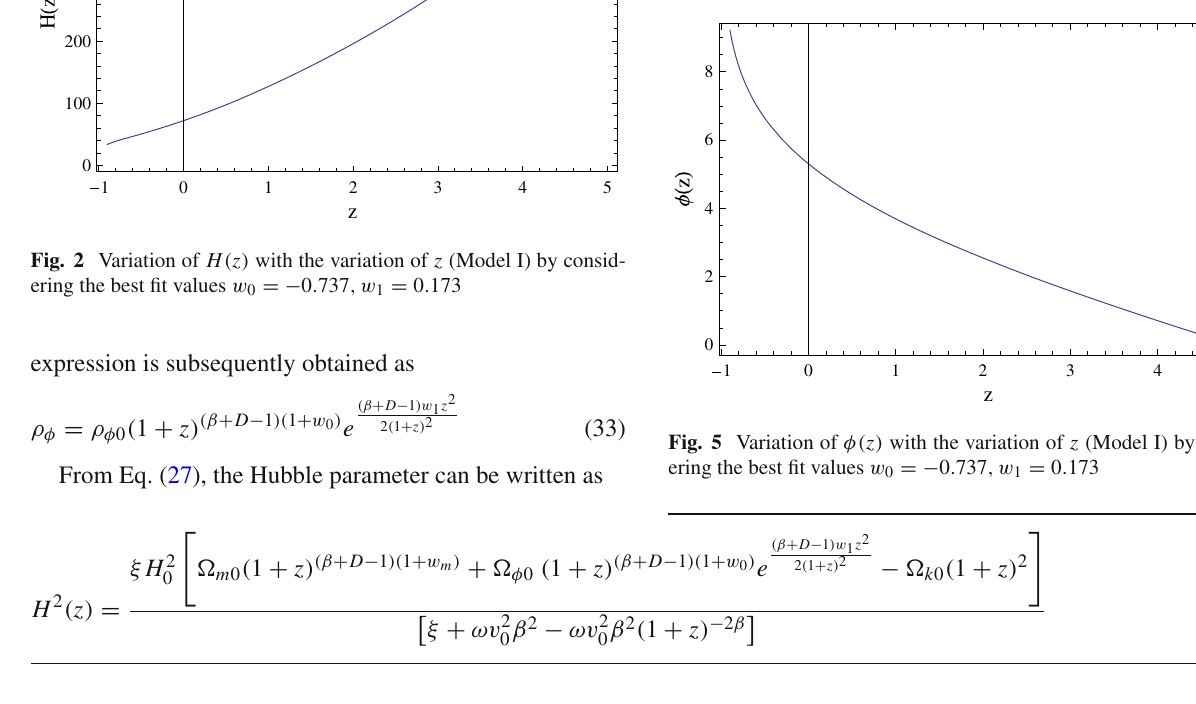
Fig. 4 Variation of f ( z ) with the variation of z (Model I) by consid- ering the best fit values w 0 = − 0 . 737 ,w 1 = 0 . 173